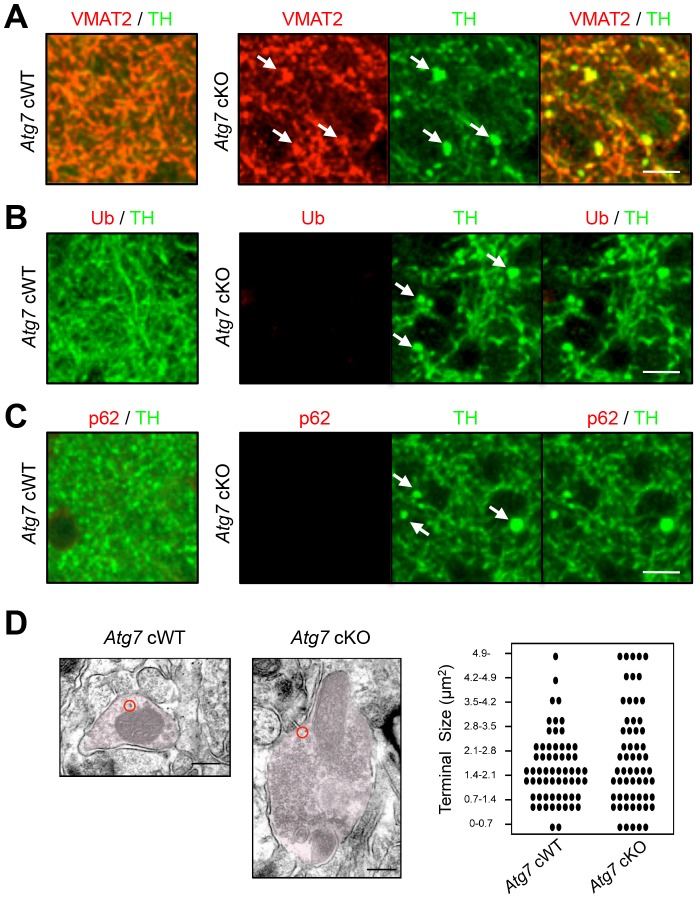
Characterization of enlarged TH-positive axon terminals of Atg7 cKO mice.(A) Enlarged axon terminals in the striatum of 2-month-old Atg7 cKO mice were positive for the axon terminal proteins of midbrain DA neurons. Enlarged axon terminals (arrows in green) in Atg7 cKO mice were stained with VMAT2 (arrows in red). Bars, 10 µm. (B, C) Enlarged axon terminals in 2-month-old Atg7 cKO mice are Ub- and p62-negative. Enlarged axon terminals (arrows in green) in the striatum of Atg7 cKO mice were not stained with the markers for protein inclusions such as Ub (red in ‘B’) and p62 (red in ‘C’), suggesting that they are distinct from the inclusions seen in the cell somas of Atg7 cKO mice (Figure 1D). Bars, 10 µm. (D) Ultrastructural analysis of dopaminergic axon terminals in the striatum of 3-month-old Atg7 cWT or Atg7 cKO mice by immunoelectron microscopy with an antibody to TH. Red circles indicate the gold particle-conjugated anti-TH antibody. Bars, 200 nm. (right) Quantification of the size distribution of axon terminals in striatal sections. Each dot (•) represents approximately 1.6% of the total axon terminal number. n = 611 terminals for cWT and 592 terminals for cKO sections.